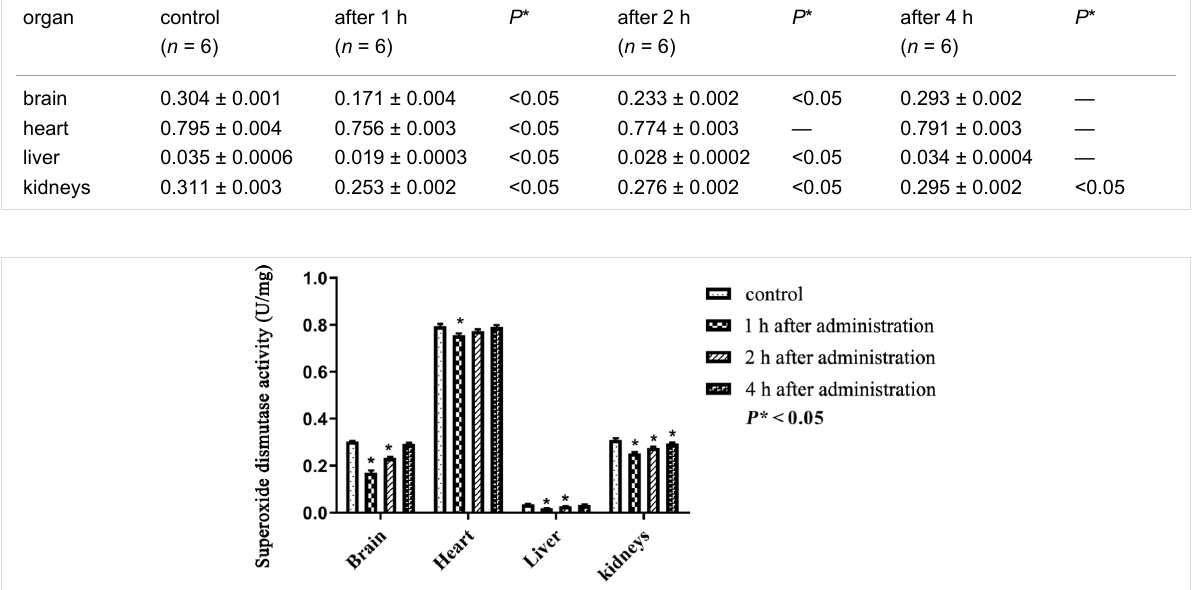
Table 4: Concentration ( μ M/mg) of reduced glutathione in different organs after administration of PEGylated nano-graphene oxide in different organs after different periods of time (mean ± standard deviation). organ